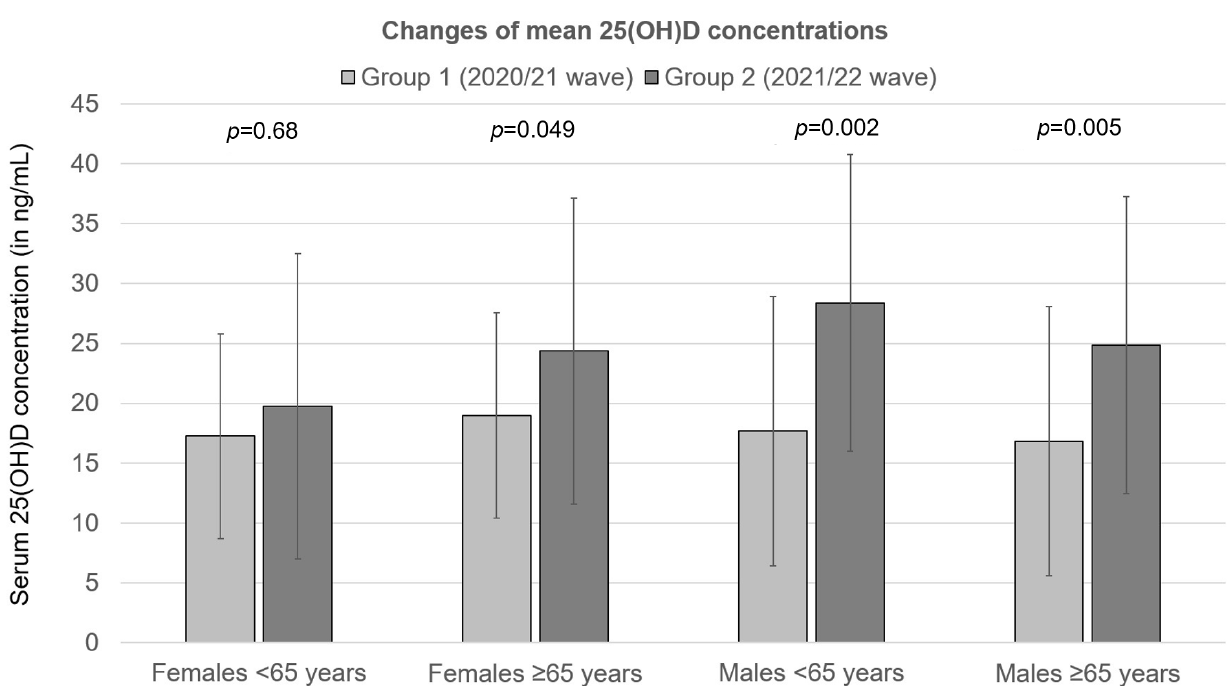
Figure 3. Changes of mean 25(OH)D concentrations in patients hospitalized for severe COVID-19 between the second (2020/21) and the third (2021/22) wave of the pandemic. Group 1—second wave (2020/21); Group 2—third wave (2021/22).